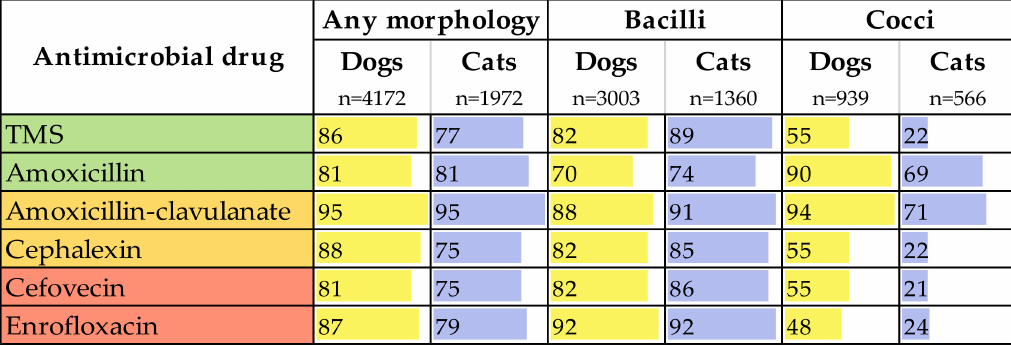
Figure 3. Impact factors of the six routinely tested antimicrobials, by isolate morphology and host species. The colors in the left column indicate the Australian Strategic and Technical Advisory Group on Antimicrobial Resistance (ASTAG) importance ratings of the antimicrobials, and the yellow and blue bars indicate the magnitude of the antimicrobial impact factor in each animal